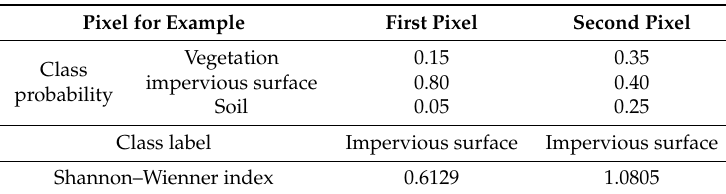
Table 1. The illustration of classification uncertainty: two pixels share the same class label, but are very different in classification uncertainty, as derived by the Shannon–Wiener